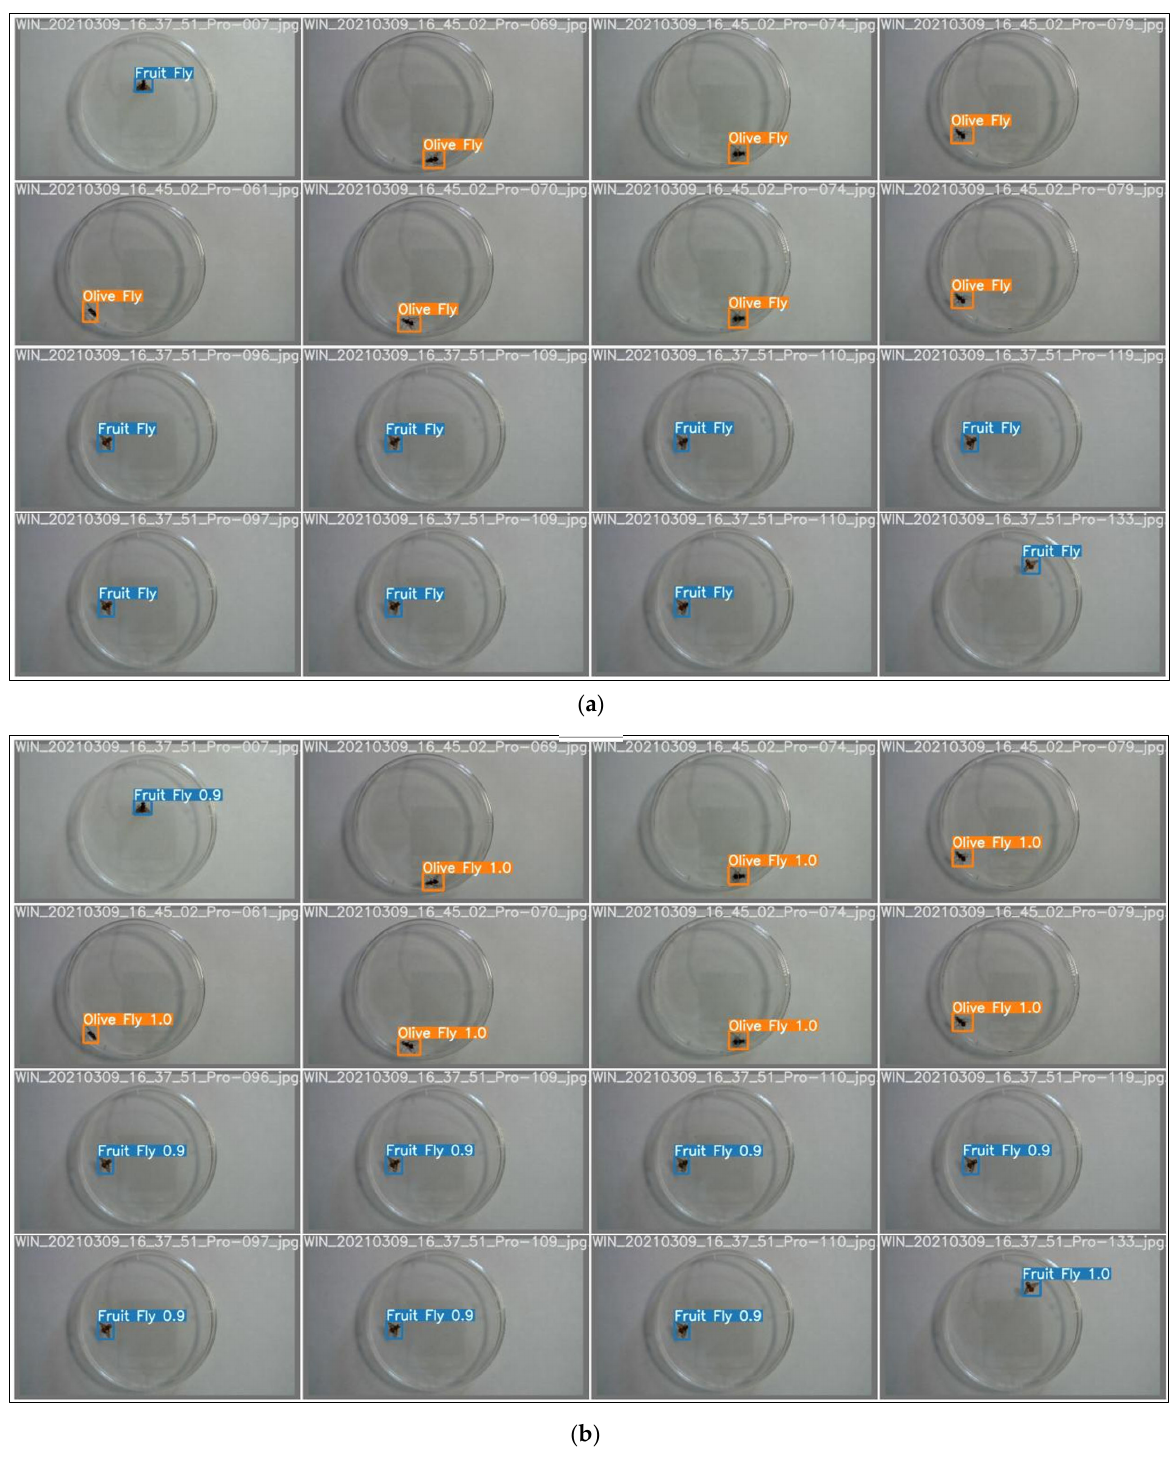
Figure 7. Training results: ( a ) labelled images of the olive fruit fly (i.e., B. oleae in the orange box) and the Mediterranean fruit fly (i.e., C. capitata in the blue box), ( b ) prediction results of the testing set with inference precision percentage.